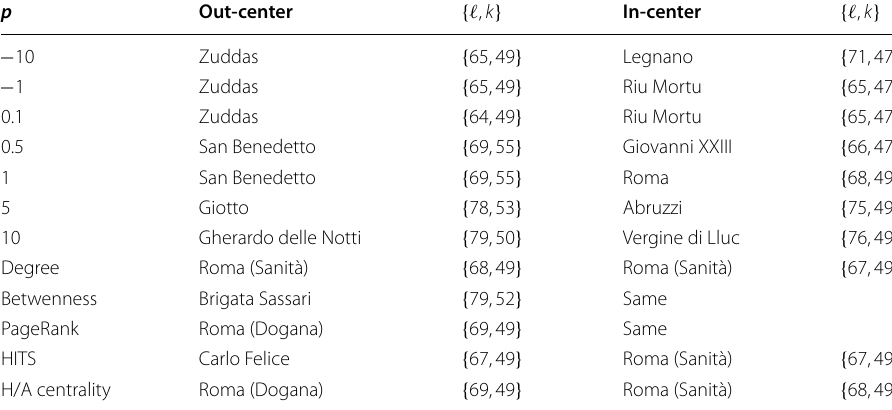
For each vertex we also report the depth ℓ of the associated spanning tree and the minimal lower bandwidth k of the corresponding { ℓ , k } -chained structure